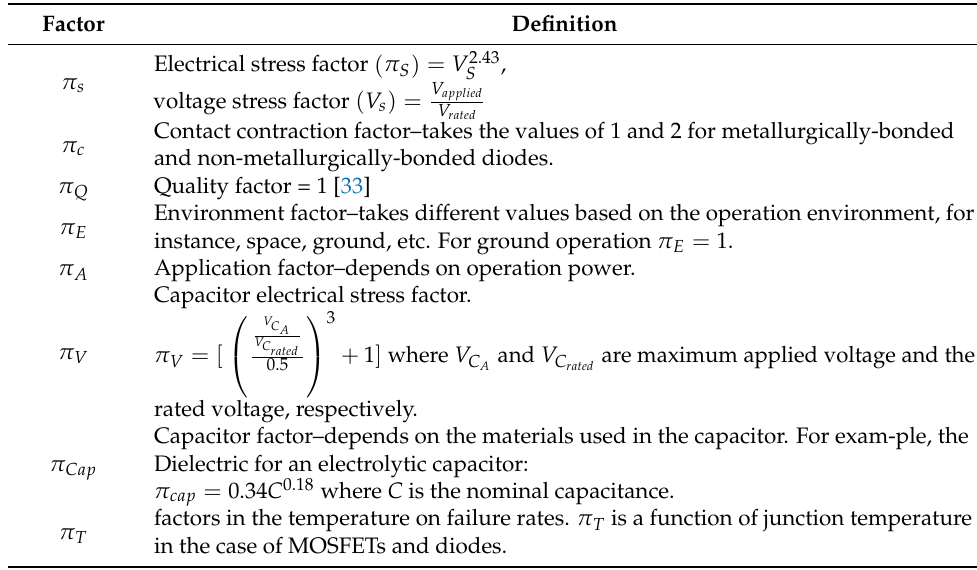
Table 2. Factors Affecting the Failure